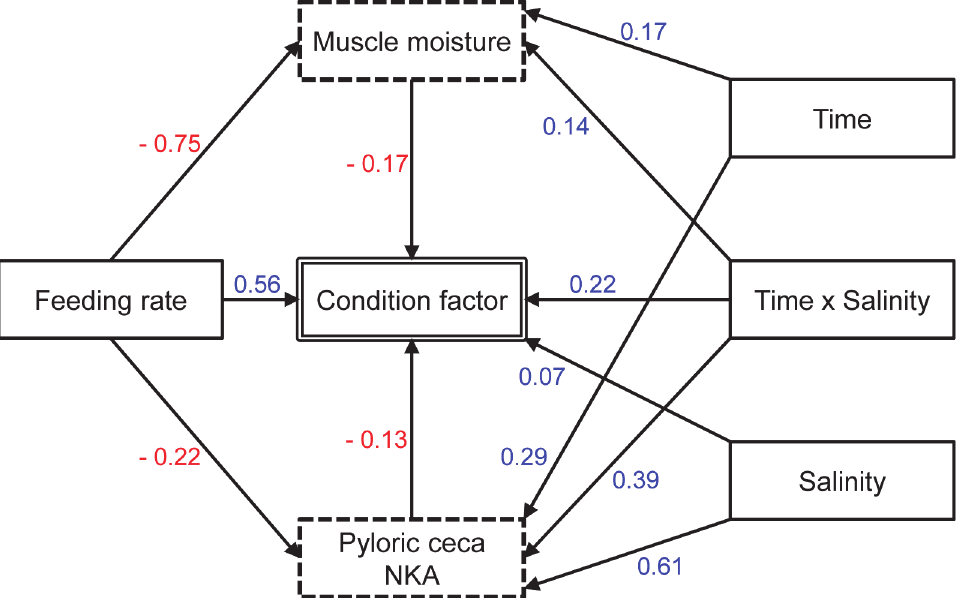
Fig 5. Fitted structural equation model for green sturgeon. Bayesian estimation was used to determine variables affecting condition factor (double-line rectangle). Solid rectangles: treatments; dashed rectangles: osmoregulation parameters. Arrows represent causal pathways between variables, each having a standardized partial regression coefficient (sign indicates whether the relationship is positive or negative for that direct effect).